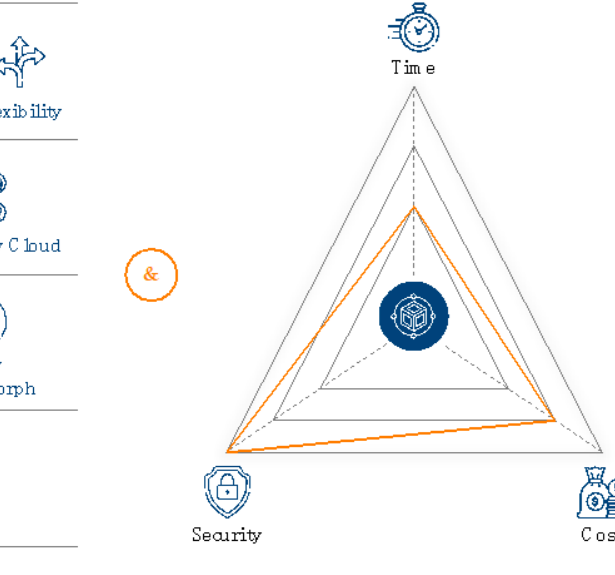
Figure 6. Identification of use